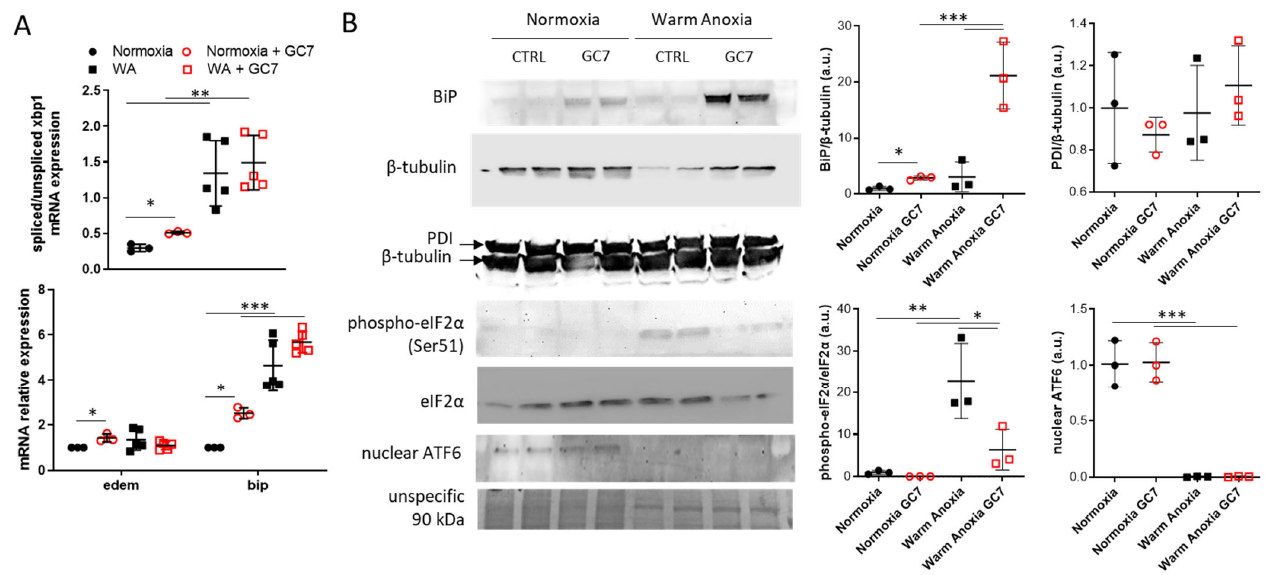
Figure 3. GC7 modulates ER stress response induced by anoxia. PCT cells pretreated for 8 h either with a vehicle or with 30 µ M GC7 and 24 h later, exposed to either normoxia or warm anoxia ( ≤ 0.1% O 2 at 37 °C for 24 h). At the end of the experiment cells were either lysed for ( A ) mRNA or ( B ) protein expression analysis. ( A ) Scatter plot representation of individual values along with mean ± SD (n = 3–5) for the ratio of spliced/unspliced xbp1 mRNA and the relative expressions of edem and bip . ( B ) Representative western blots of BiP, PDI, eIF2 α (total and phosphorylated on Ser51 site) and ATF6 protein levels and the scatter plot representation of normalized individual values along with mean ± SD, n = 3. * = p ≤ 0.01; ** = p ≤ 0.001; *** = p ≤ 0.0001.